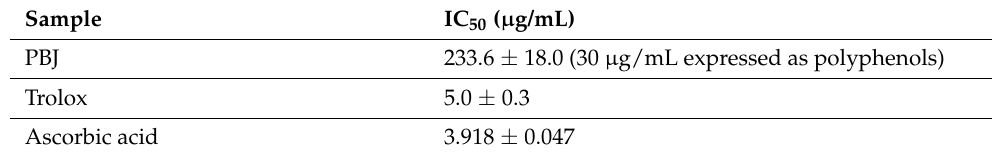
Table 3. Radical scavenging activity of PBJ.